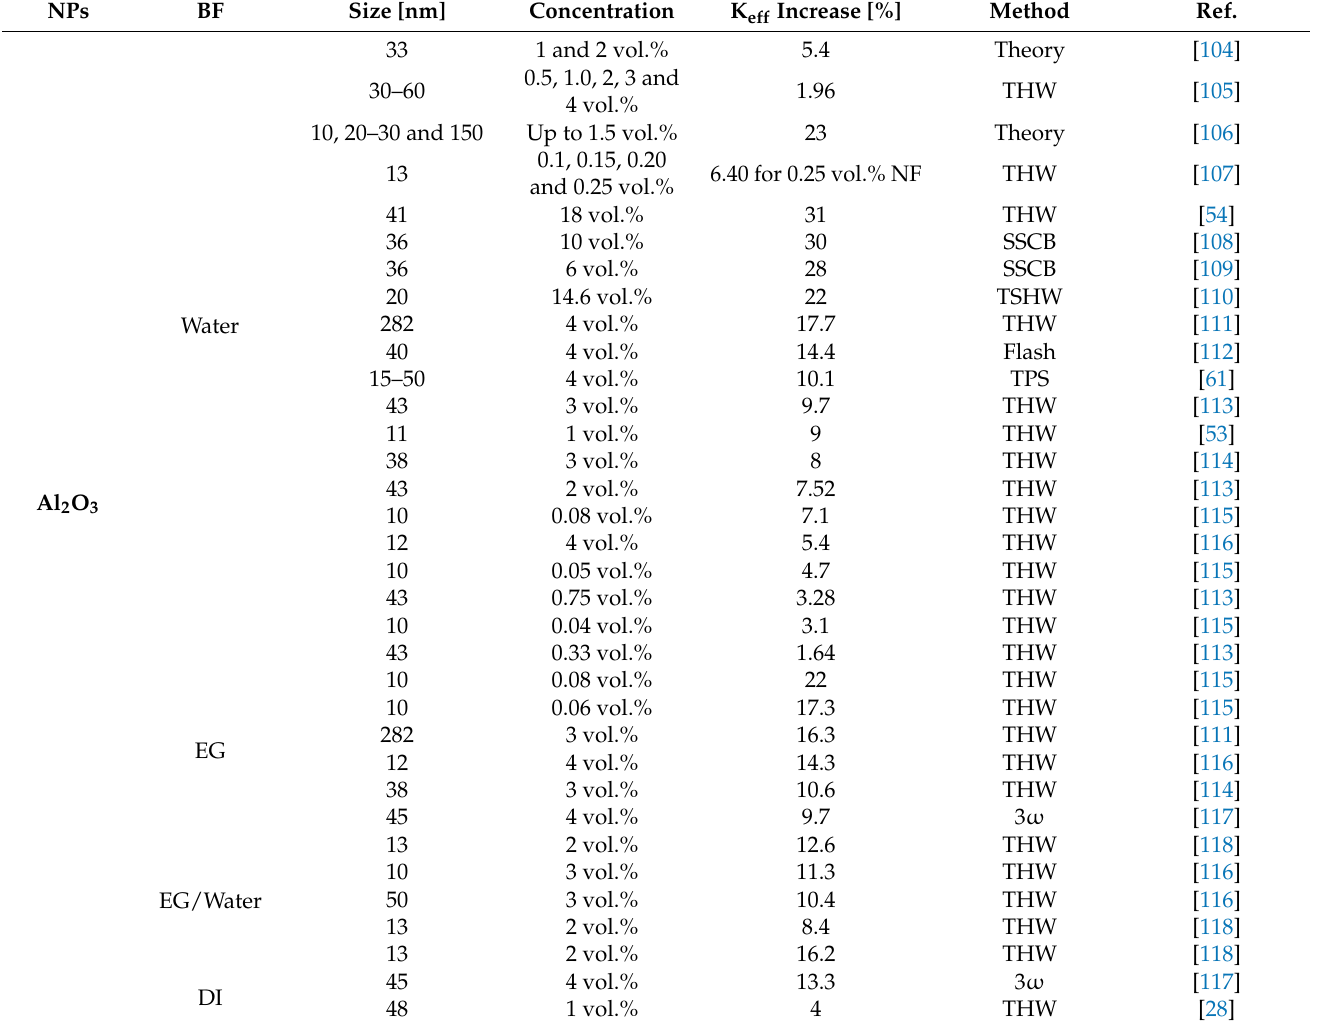
Table 3. Thermal conductivity enhancement measurements for different nanofluids (NFs). NPs BF Size [nm] Concentration K eff Increase [%] Method Ref.